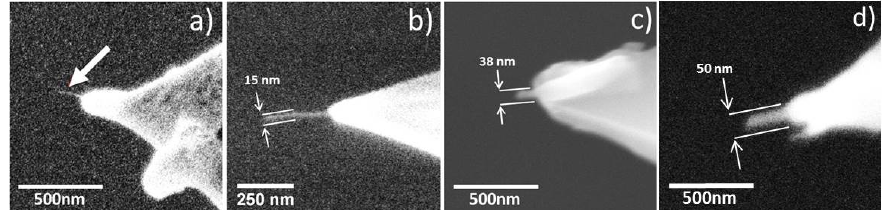
Figure 2. SEM images of the CNT probes used in this work, designated ( a ) CNT1. ( b ) CNT2. ( c ) CNT3 and ( d )